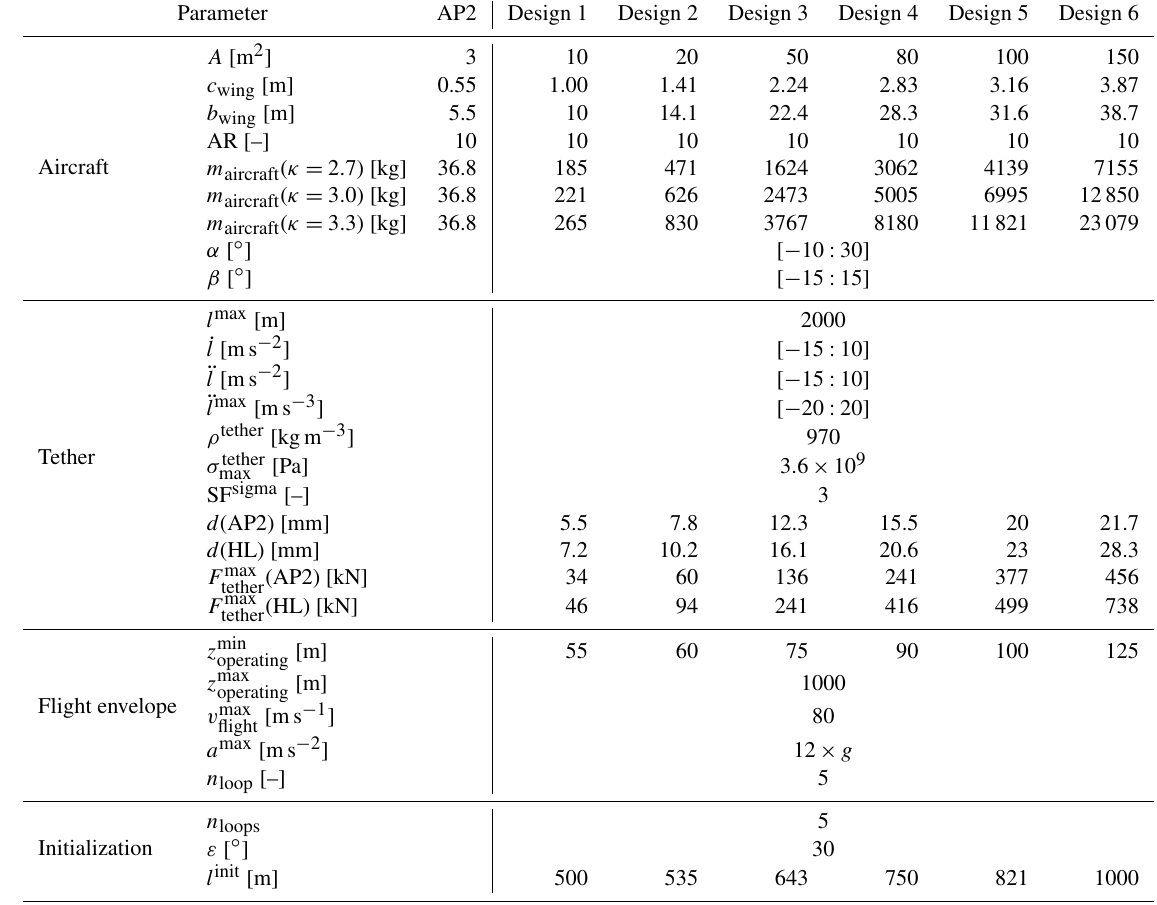
Table 1. List of investigated AWES design parameters and selected system constraints for the six investigated designs with different wing sizes (10m 2 ≤ A ≤ 150m 2 ) with the original AP2 design as reference. The two different aerodynamic configurations (AP2 and HL) deter- mine tether diameter d and maximum tether force F max tether